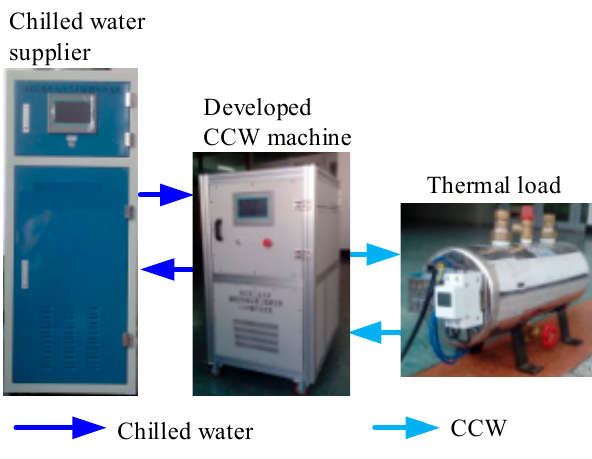
Figure 10. Experimental setup.